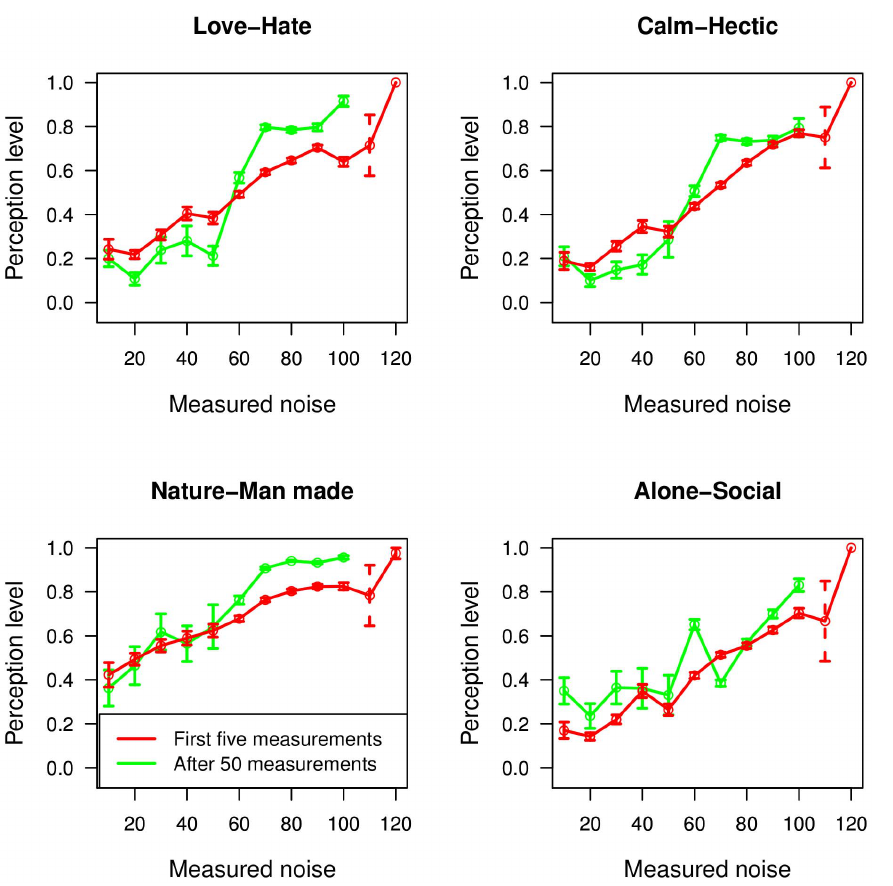
Figure 15. Perception evaluation versus the measured noise level. The red lines display the average evaluation over the first five measurements of all users; the green lines correspond to the average evaluation over the set of all measures taken by users starting from the 50th one.